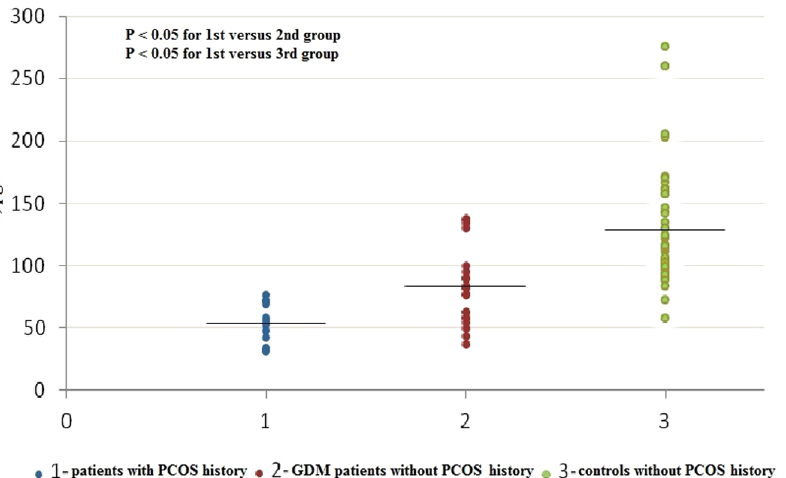
Figure 1. Scattergram of serum FGF19 levels in patients with PCOS history, GDM patients without PCOS history. Horizontal lines across the scatter diagram represent median values. Differences between groups were assessed by Mann-Whitney U test with Bonferroni adjustment for multiple testing.